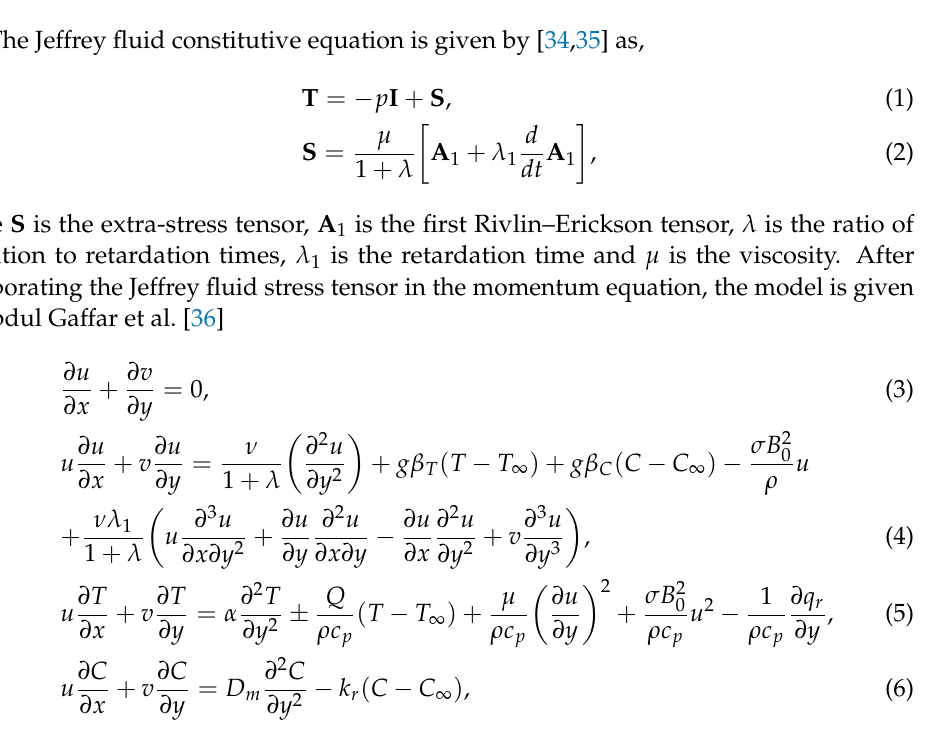
Figure 1. Schematic flow diagram and coordinate